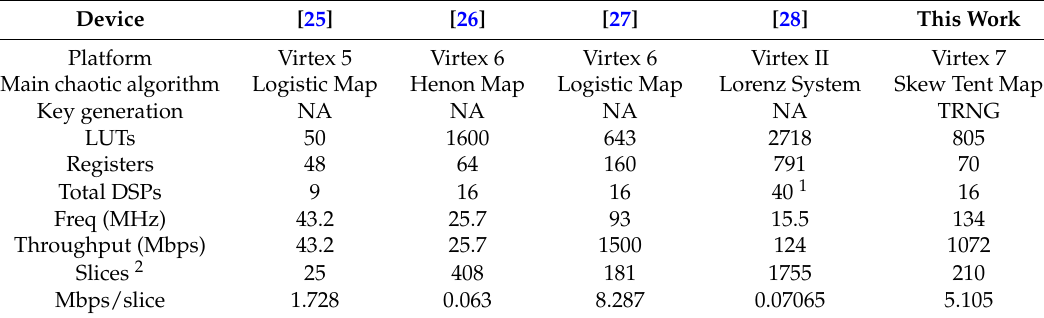
Table 2. Comparison with Recent Published Chaos-Based